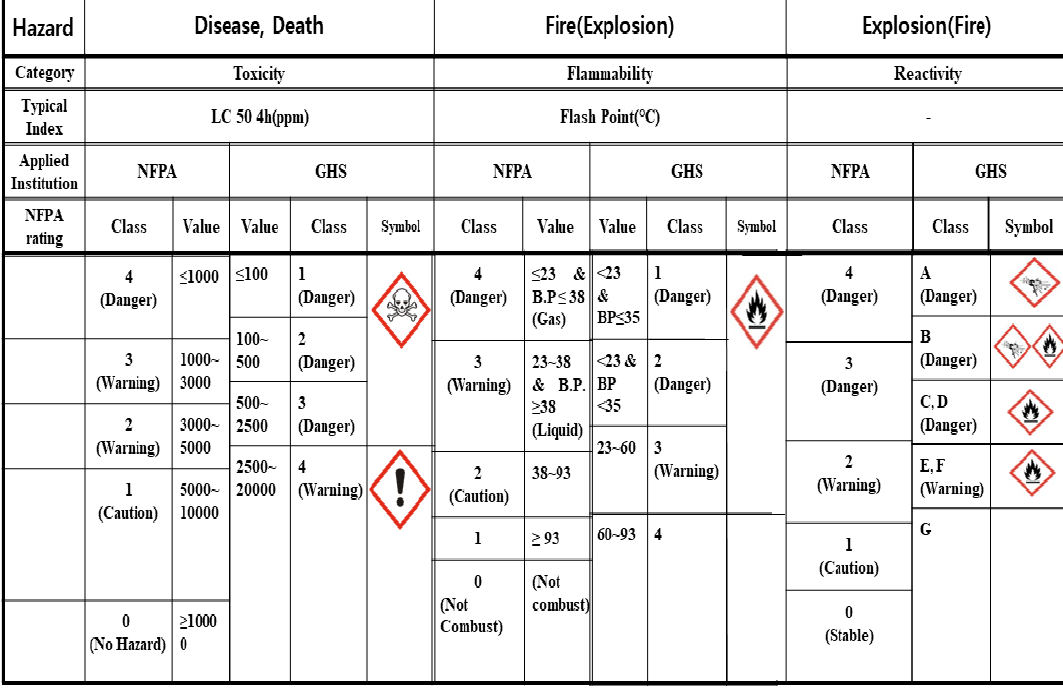
Figure 8. Chemical classification table linking the standard system for the identification of the hazard of materials for emergency response based on the U.S. National fire protection association (NFPA 704) and the globally harmonized system of classification and labeling of chemicals (GHS) standards.